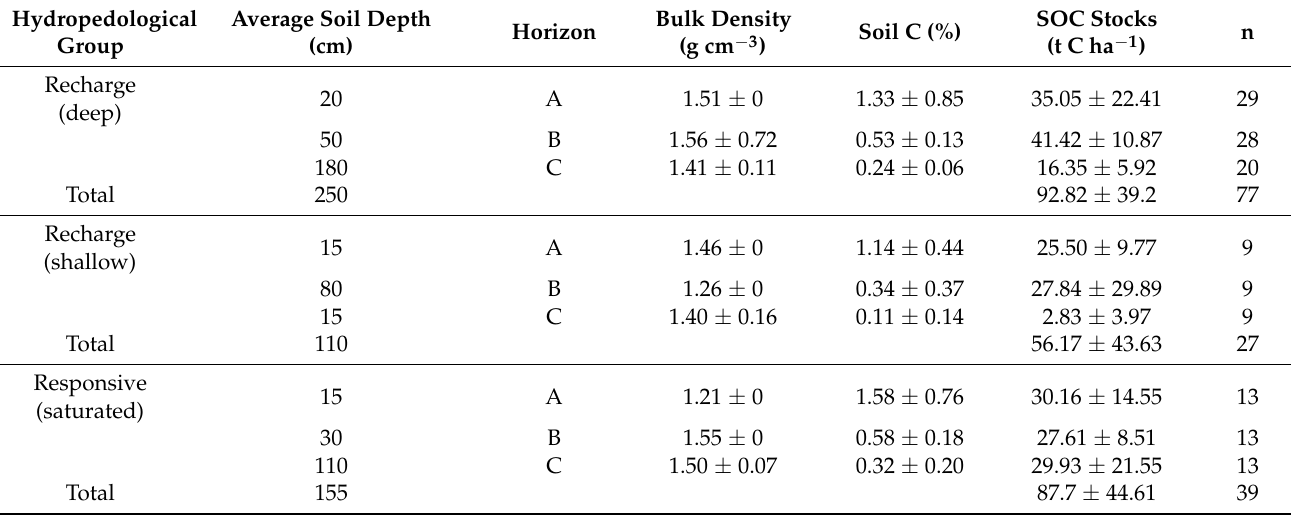
Table 2. Summary of the mean soil bulk density, C content, and SOC stocks for each hydropedological group at the respective soil horizons (mean ± standard